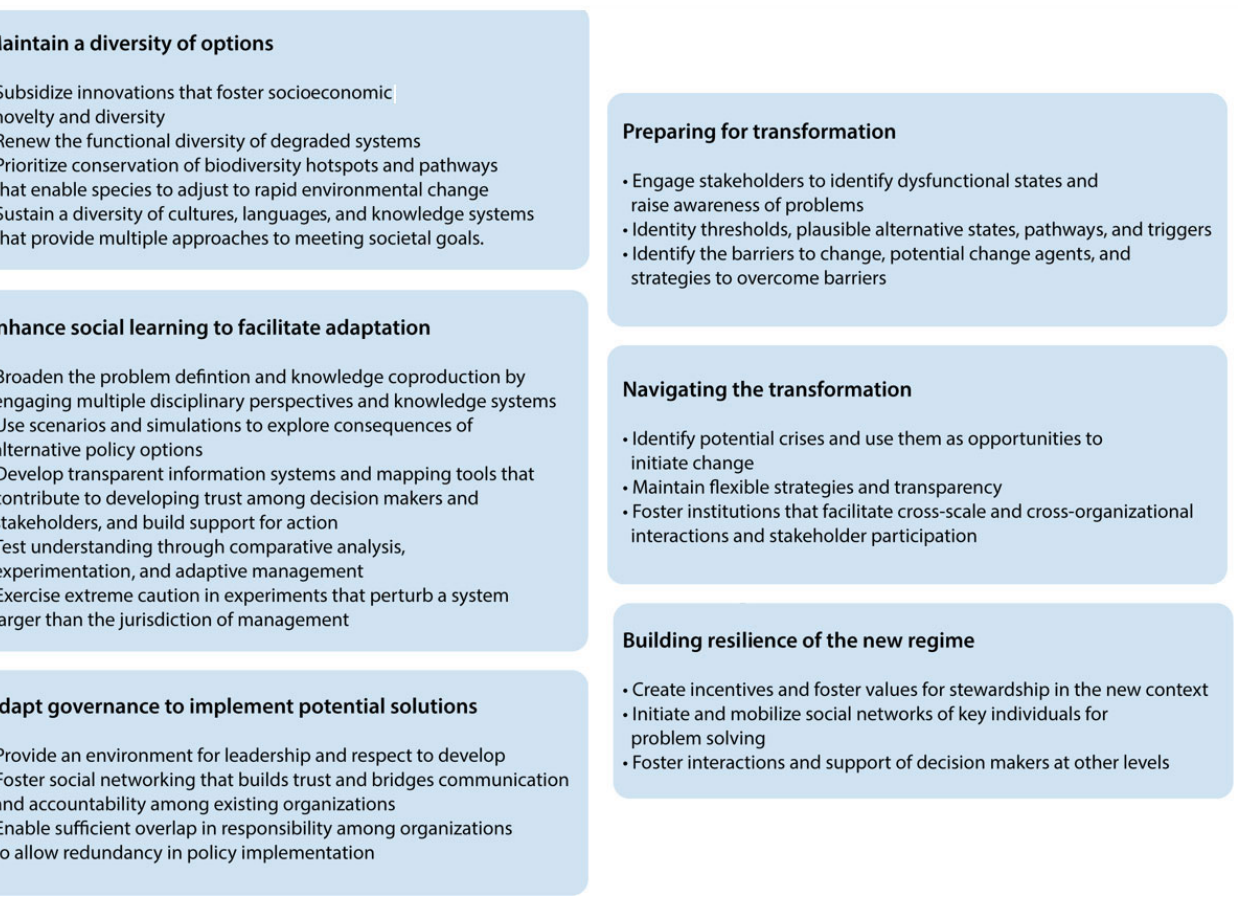
Fig. 1 . Examples of stewardship strategies for dealing with uncertainty and change and strategies to transform from unsustainable social-ecological pathways to potentially more favorable ones (modified from Chapin et al.